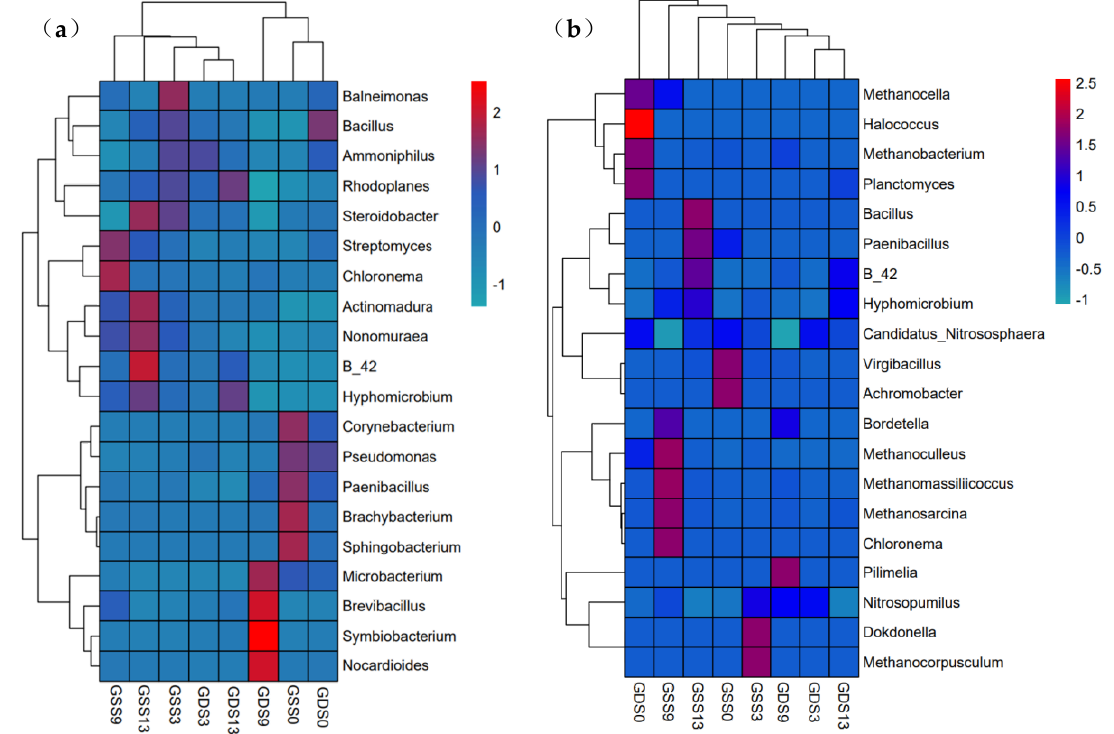
Figure 4. Cluster heat map analysis of species abundance of soil microbial community at different planting years. ( a ) the cluster heat map analysis of the top 20 genera by relative abundance in the bacterial community; ( b ) the cluster heat map analysis of the top 20 genera by relative abundance in the archaeal community.